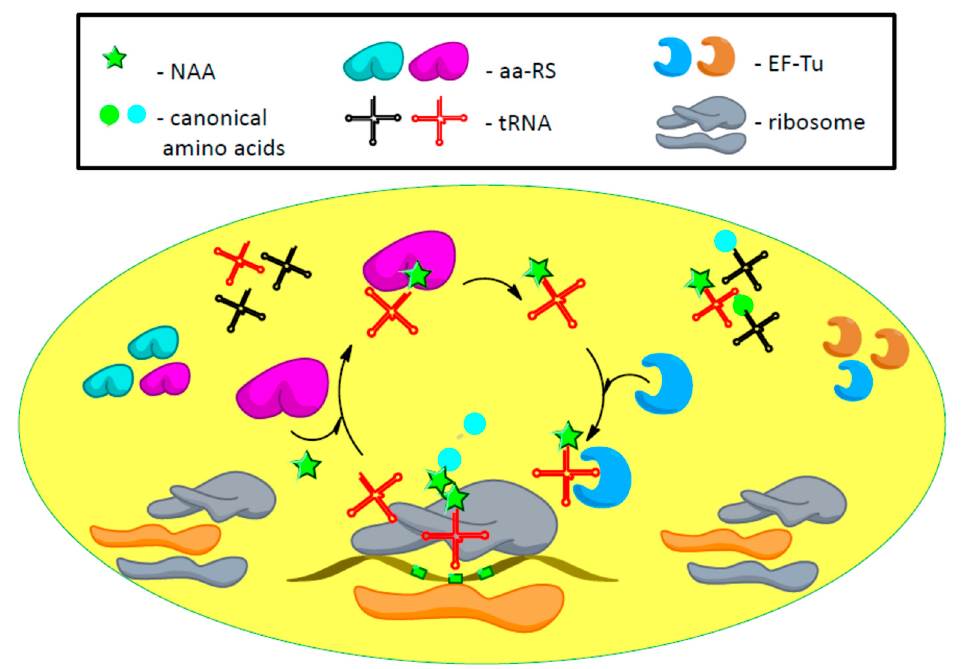
Figure 3. Improved orthogonal translation system includes aa-RS with enhanced enzymatic efficiency, optimized tRNA and evolved EF-Tu (shown by blue colour). Moreover, the overall efficiency of nonsense suppression is achieved due to the sequestration of RF1 from the translation process by application of orthogonal mRNA and 30S orthogonal ribosome subunit or by exploiting genetically recoded E. coli lacking RF1.